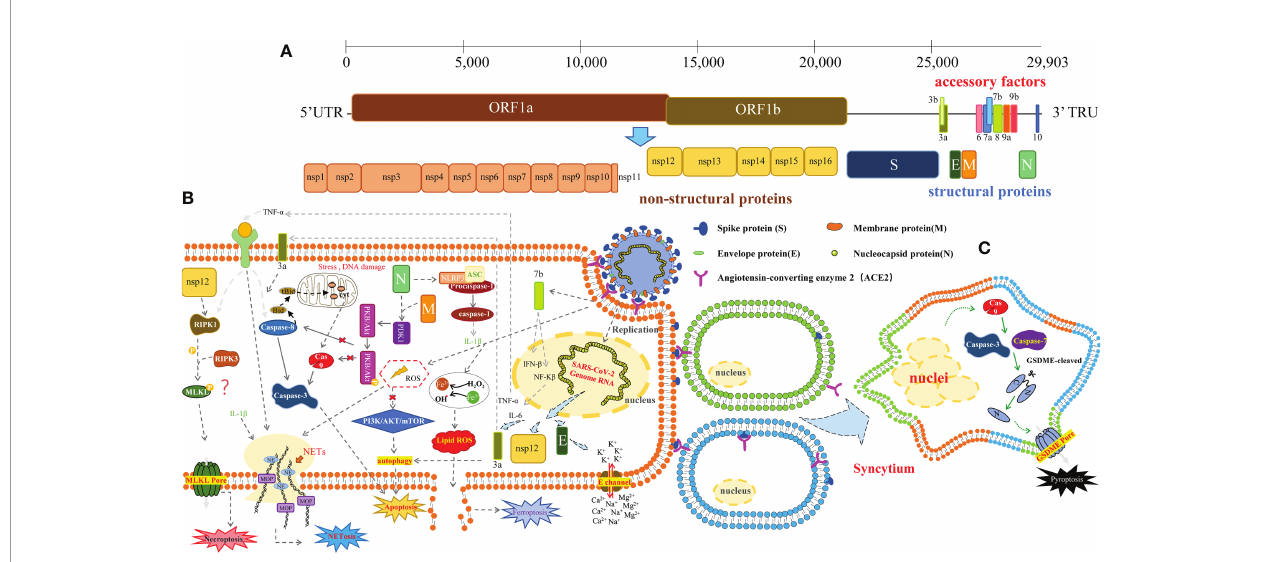
FIGURE 1 | The schematic of SARS-CoV-2-induced cell death. (A) The SARS-CoV-2 virus particle and genome. The genome is a single-stranded RNA genome of which the full length is 29,903 bp. It includes ORF1a and ORF1b, which encode the 16 non-structural proteins, 9 accessory factors, and 4 structural proteins: spike protein (S), envelope protein (E), mbrane protein (M), and nucleocapsid protein (N). (B) SARS-CoV-2 induces various cellular stress: apoptosis , triggered by the extrinsic pathway (death receptor pathway), or the intrinsic pathway (mitochondrial pathway), involving the caspase cleavage. SARS-CoV-2 ORF3a caused apoptosis via the caspase-8/Bid extrinsic pathway; ORF7b can activate TNF a -induced apoptosis. Membrane (M) protein with nucleocapsid (N) protein via interacting with PDK1 and inhibiting the activation of PDK1- PKB/Akt signaling to trigger caspase-dependent apoptosis. Another structural protein spike of SARS-CoV-2 also induced autophagy and apoptosis by ROS-suppressed PI3K/AKT/mTOR signaling; necroptosis , mediated by RIPK1/RIPK3/MLKL. MLKL can be recruited by the autophosphorylated RIPK3 and subsequently phosphorylated by RIPK3 of human MLKL. Phosphorylated MLKL will form an MLKL pore, resulting in necroptosis. Nsp12 interacted with RIPK1 and activated it; NLRP3 in fl ammasome , consisting of NLRP3, ASC, and caspase-1, activated by N protein of SARS-CoV-2 interacted directly with NLRP3; SARS-CoV-2 E proteins form cation channels to trigger cell death independent of MLKL and gasdermins; NETosis, triggered by neutrophils and formed neutrophil extracellular traps (NETs) to release of chromatin structures containing myeloperoxidase and antimicrobial proteins to neutralize intruders. MPO, myeloperoxidase; NE, Neutrophil Elastase. Ferroptosis , triggered by iron accumulation and overload, or reactive oxygen species (ROS). (C) Pyroptosis , mediated by the gasdermin (GSDM) protein family. The N-terminal fragments of GSDM protein could induce the formation of membrane pores. SARS-CoV-2 S induces cell – cell fusion and syncytia formation driving caspase-9/GSDME-mediated syncytia